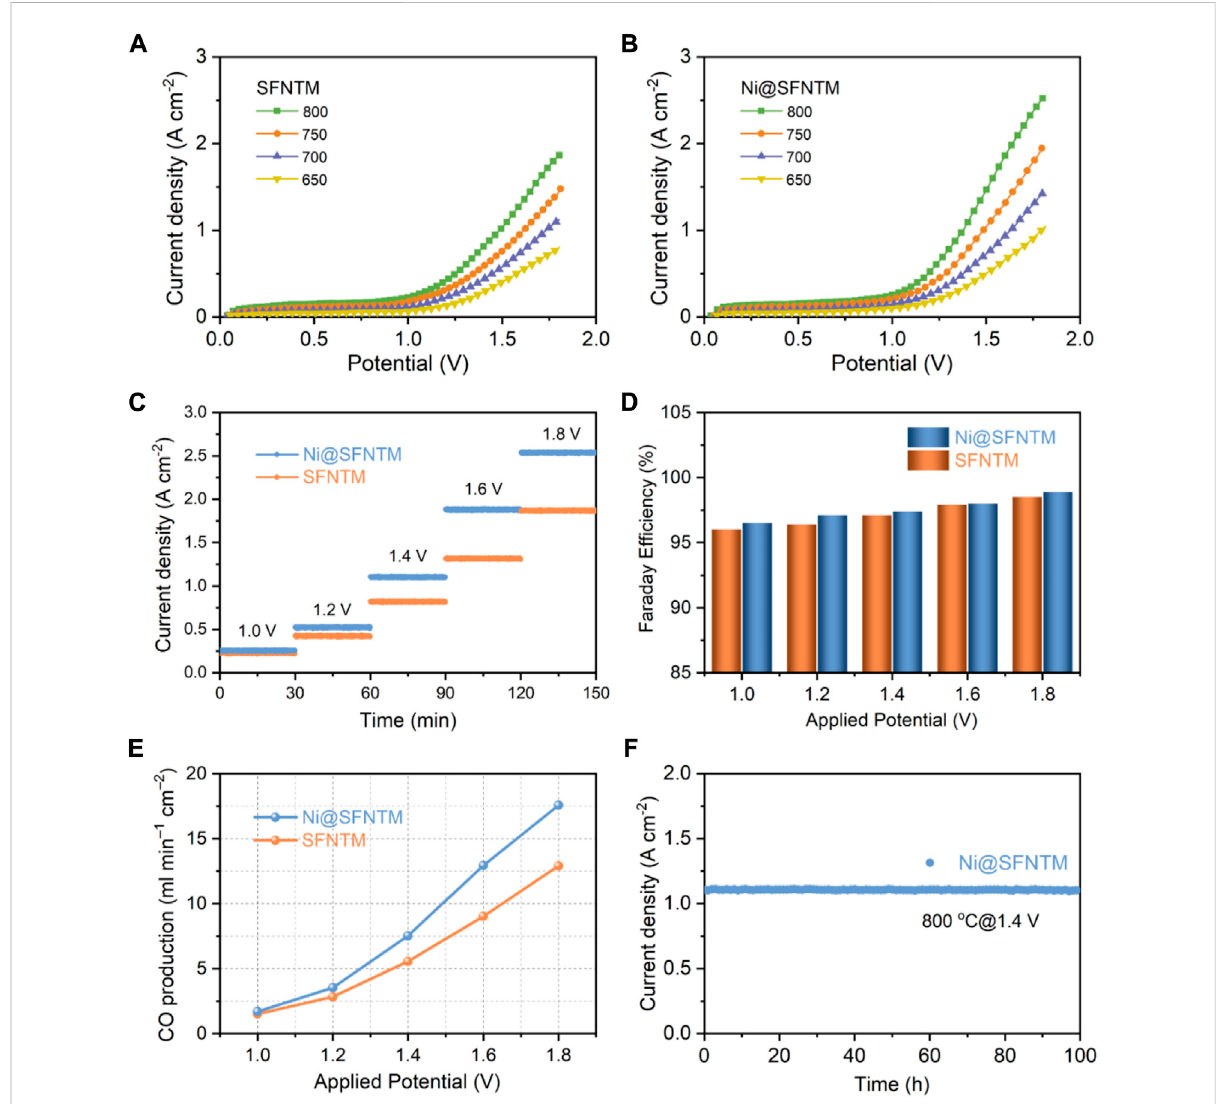
Electrochemical performance of (A) SFNTM and (B) Ni@SFNTM samples under pure CO 2 atmosphere, (C) Short-term stability under different applied potentials at 800 ° C, (D) Comparison of Faradaic ef fi ciency under different application potentials, and (E) corresponding CO production